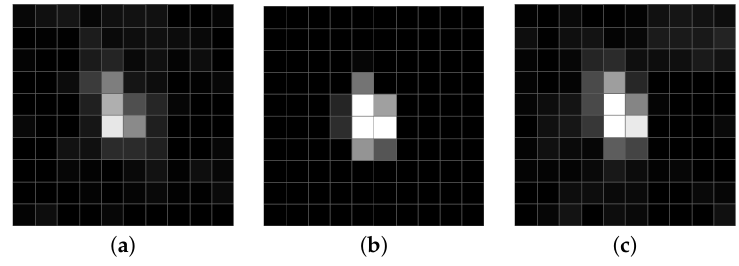
Figure 2. Detail of the static stellar object. ( a ) Time T. ( b ) Time T + 30 ms. ( c ) Time T + 60 ms.